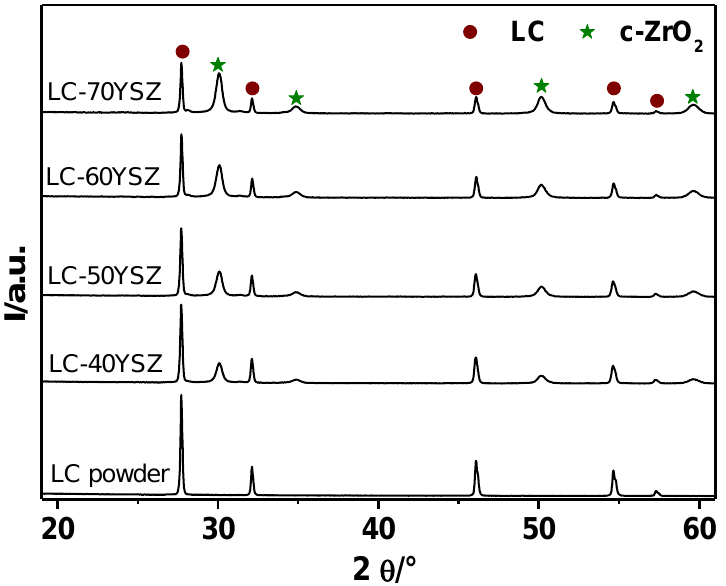
Figure 1. XRD patterns of LC-YSZ composite powders prepared by conventional mixing.